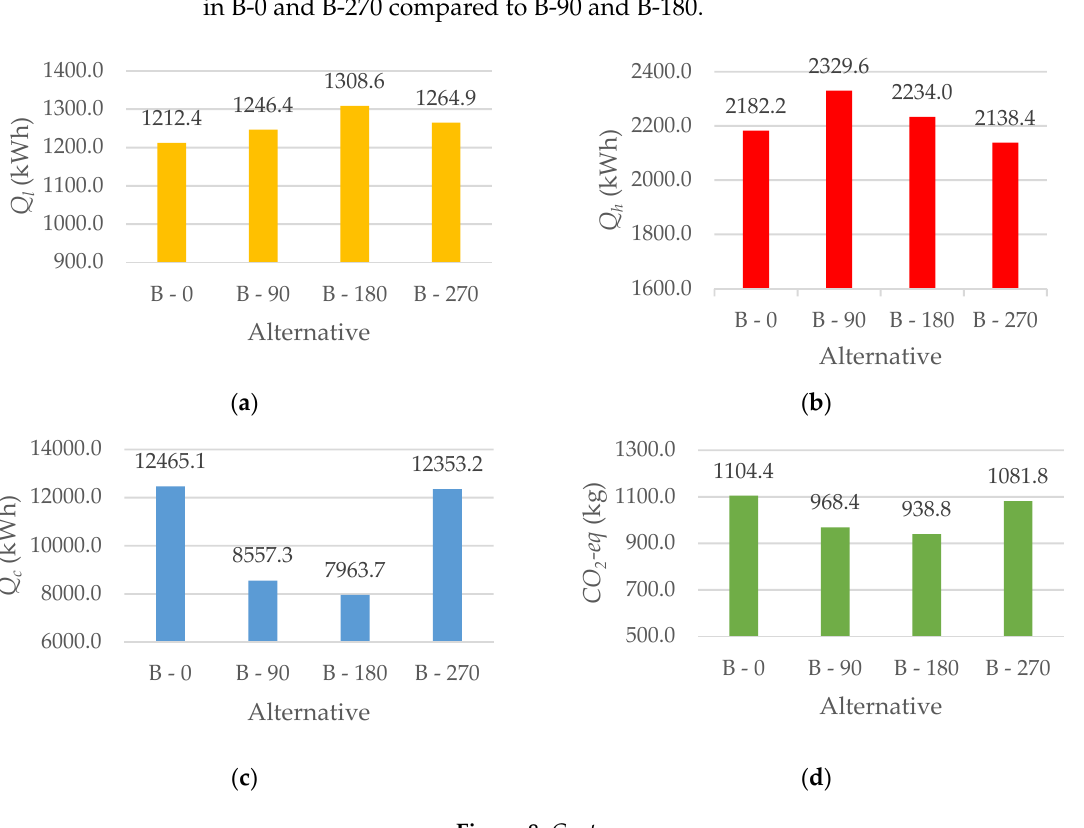
( f ) Figure 8. Annual profiles of the considered objective functions for different orientations of the building type B: ( a ) annual profiles of Q l ; ( b ) annual profiles of Q h ; ( c ) annual profiles of Q c ; ( d ) annual profiles of CO 2 -eq ; ( e ) annual profiles of AAPPD ; ( f ) annual profiles of AUDI Discomfort . Table 5. The TOPSIS results for different orientations of the building type B. Alternative Normalized Objective Functions ( F )